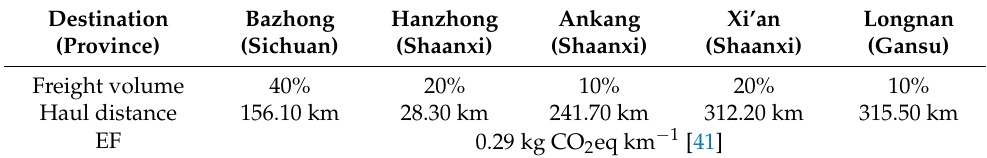
Table 5. Transport phase data